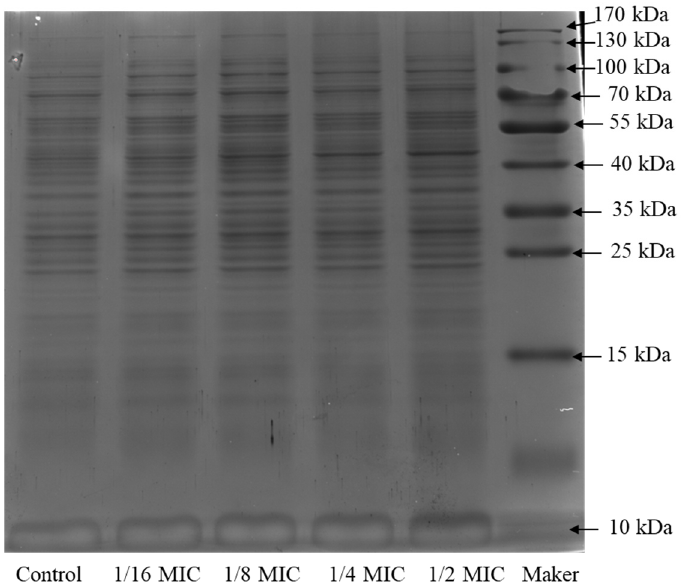
Pcc S1 treated by